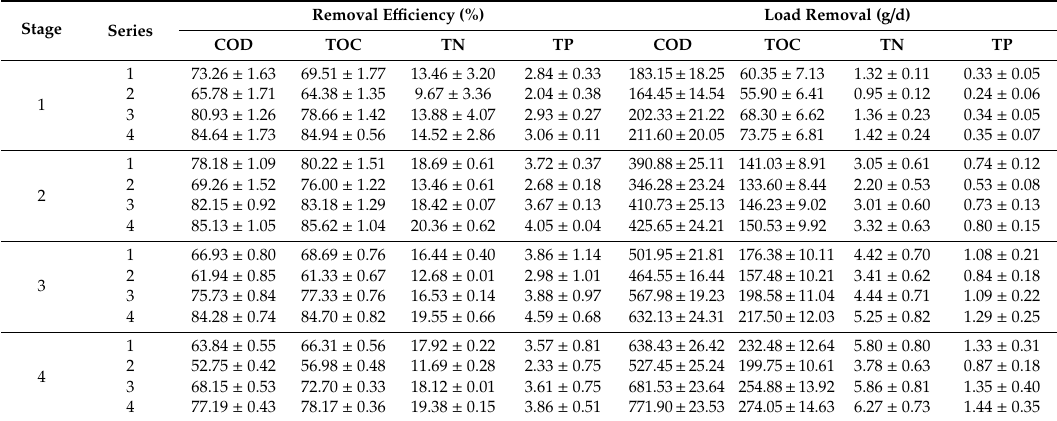
Table 3. The e ffi ciency of organic compounds and nutrient removal from dairy